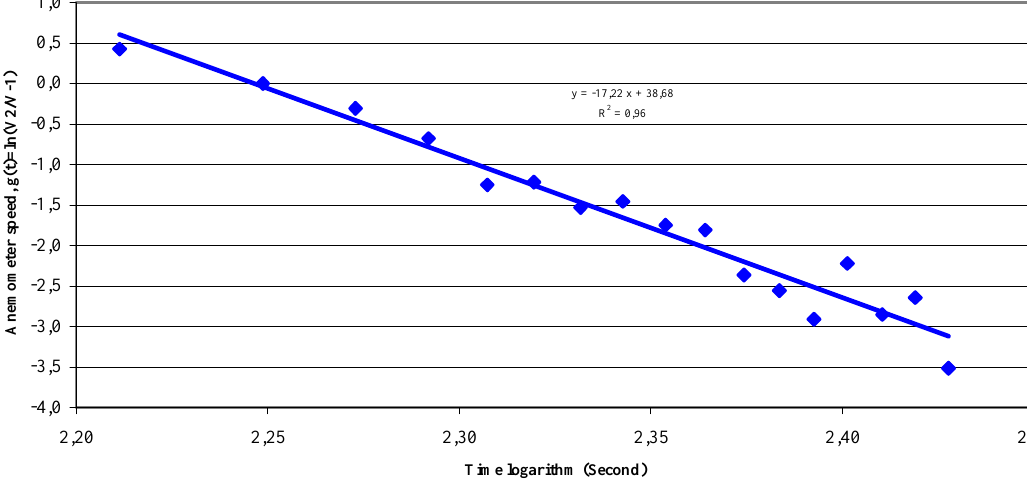
y = -17,22 x + 38,68 R 2 = 0,96